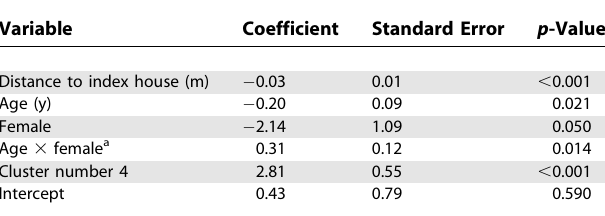
Table 4. Results of Multivariate Logistic Regression Analysis Variable